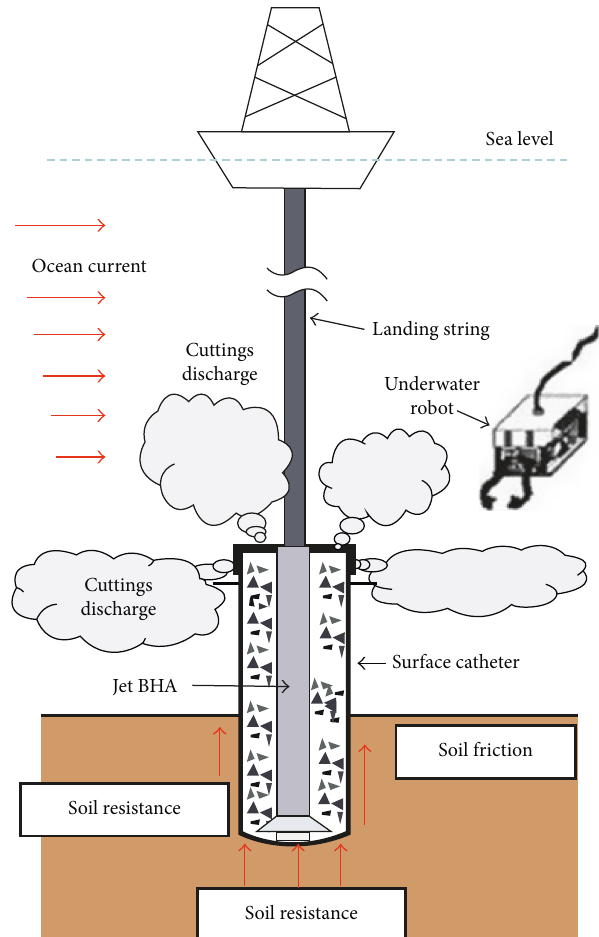
Figure 1: Schematic diagram of a landing string with the riserless drilling